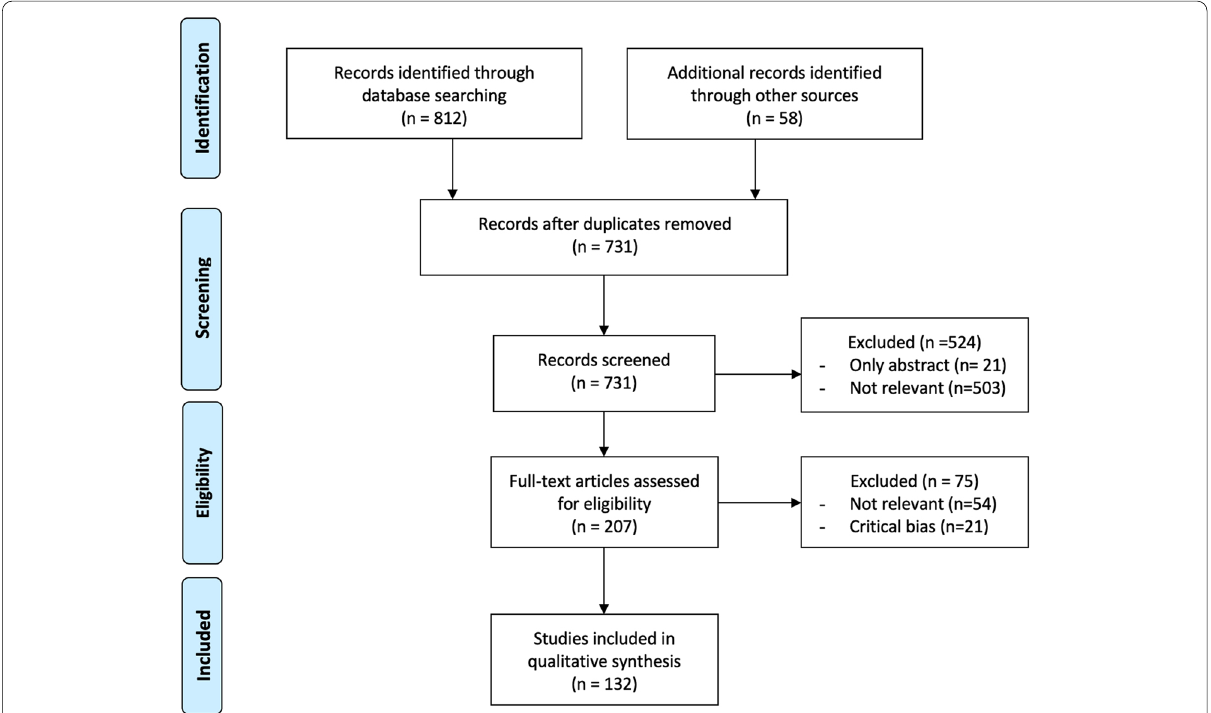
Fig. 1 Flow chart showing initial literature search for data extraction from the final list of included